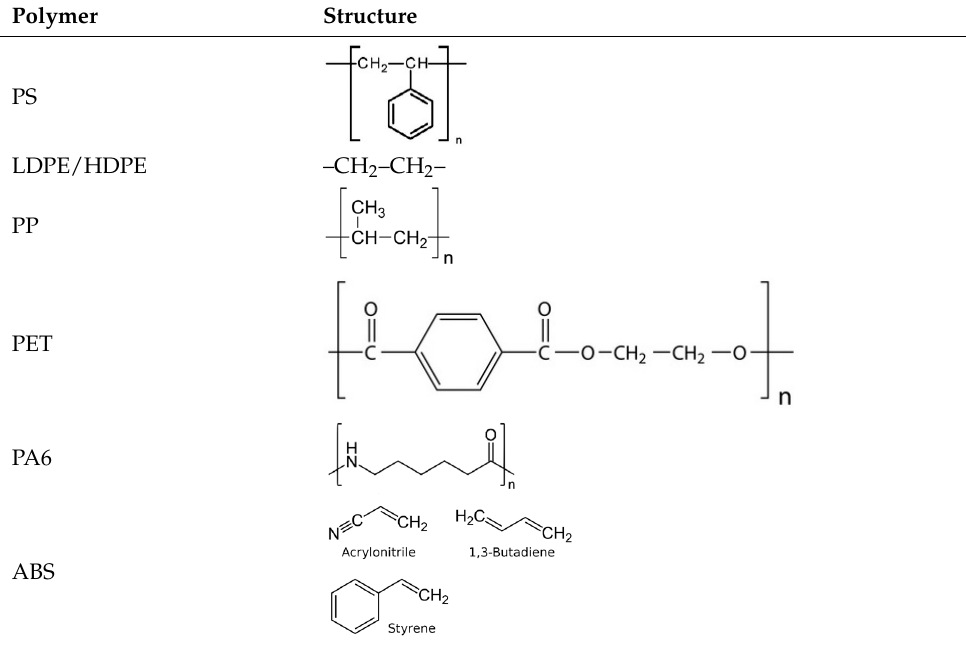
Table 1. Chemical structure of the polymers used as a carbon precursor.